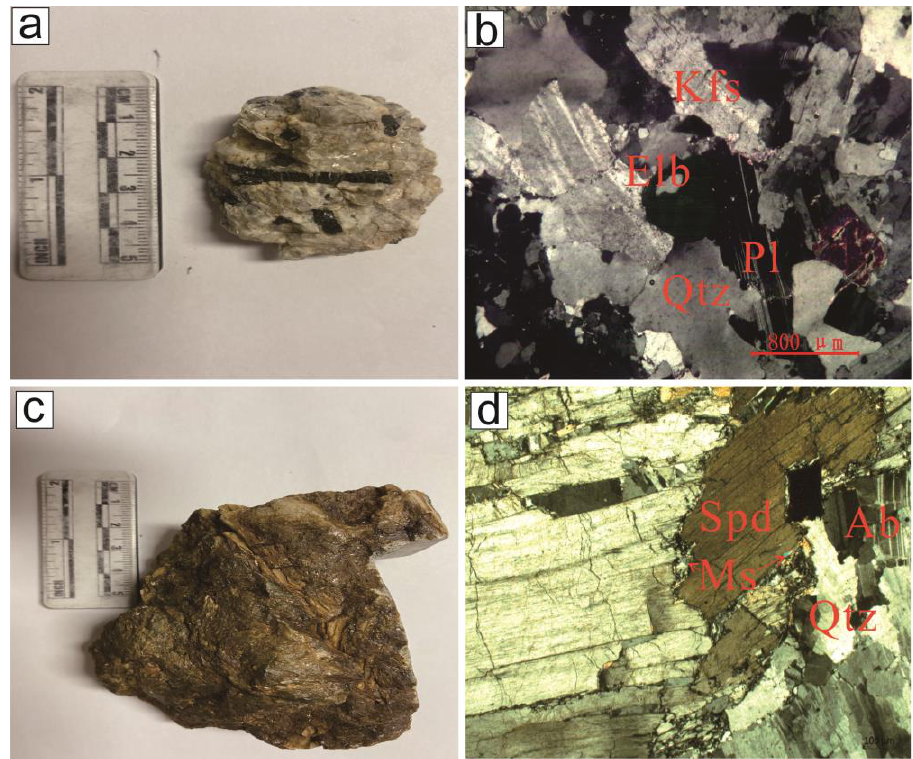
Figure 3. Photos of specimens and microscopic images of pegmatites. ( a ) Li-poor pegmatite specimens; ( b ) Li-poor pegmatite microscopic images; ( c ) Li-rich pegmatite specimens; ( d ) Li-rich pegmatite microscopic images. Spd — spodumene; Qtz — quartz; Elb — tourmaline; Ab — albite; Pl — plagioclase; Kfs — K-feldspar; Ms — muscovite.